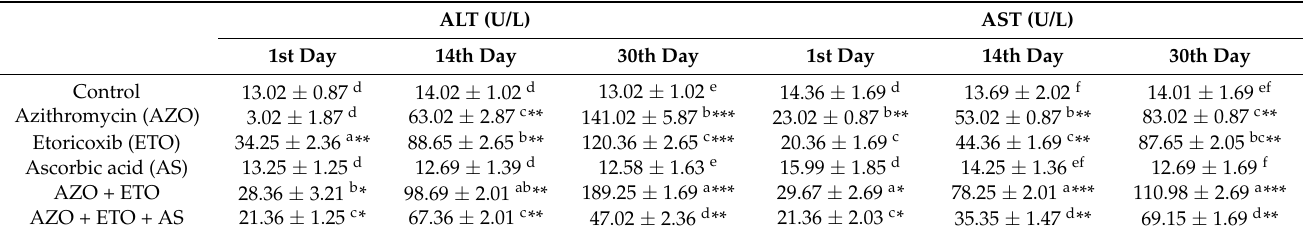
Table 2. Effects of ascorbic acid on hepatic enzymes in male rats after 30 days of administration of either azithromycin or etoricoxib or their combinations.